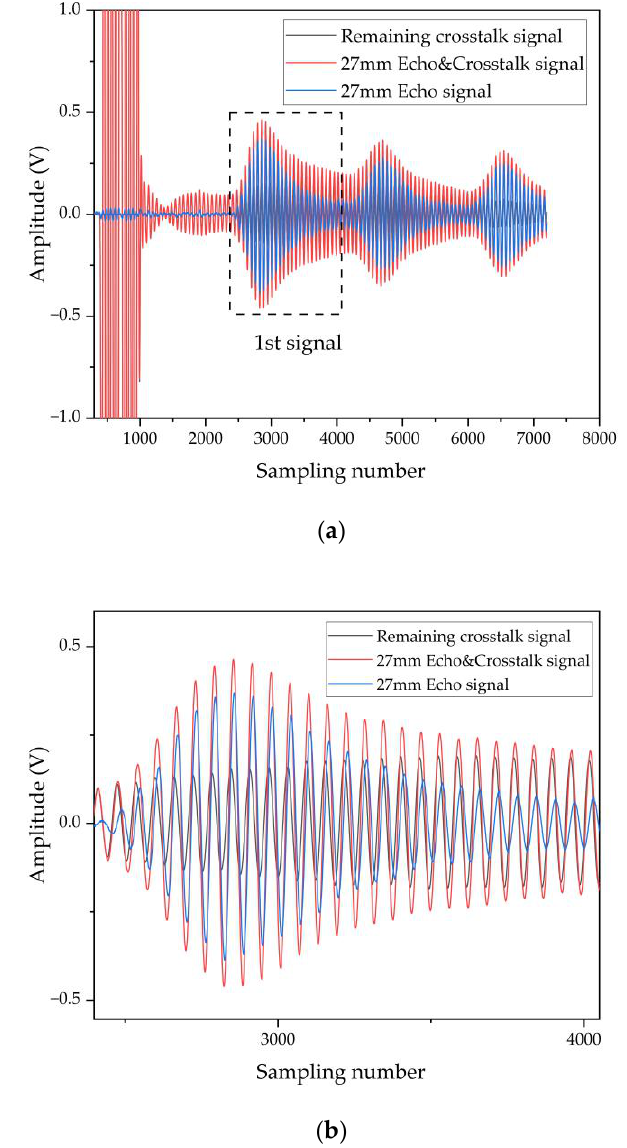
Figure 5. ( a ) Pulse echo measurement at 27 mm in distance and remaining crosstalk signal. ( b ) The detail of 1st signal.